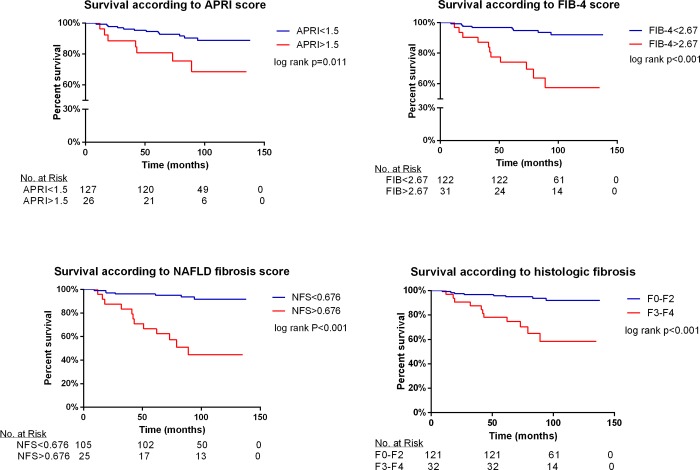
Kaplan-Meier's analysis: survival during the follow-up, according to fibrosis stage, APRI score, FIB-4 score and NAFLD fibrosis score.The number of patients, according to their corresponding scores, in each time point is shown below each graph.